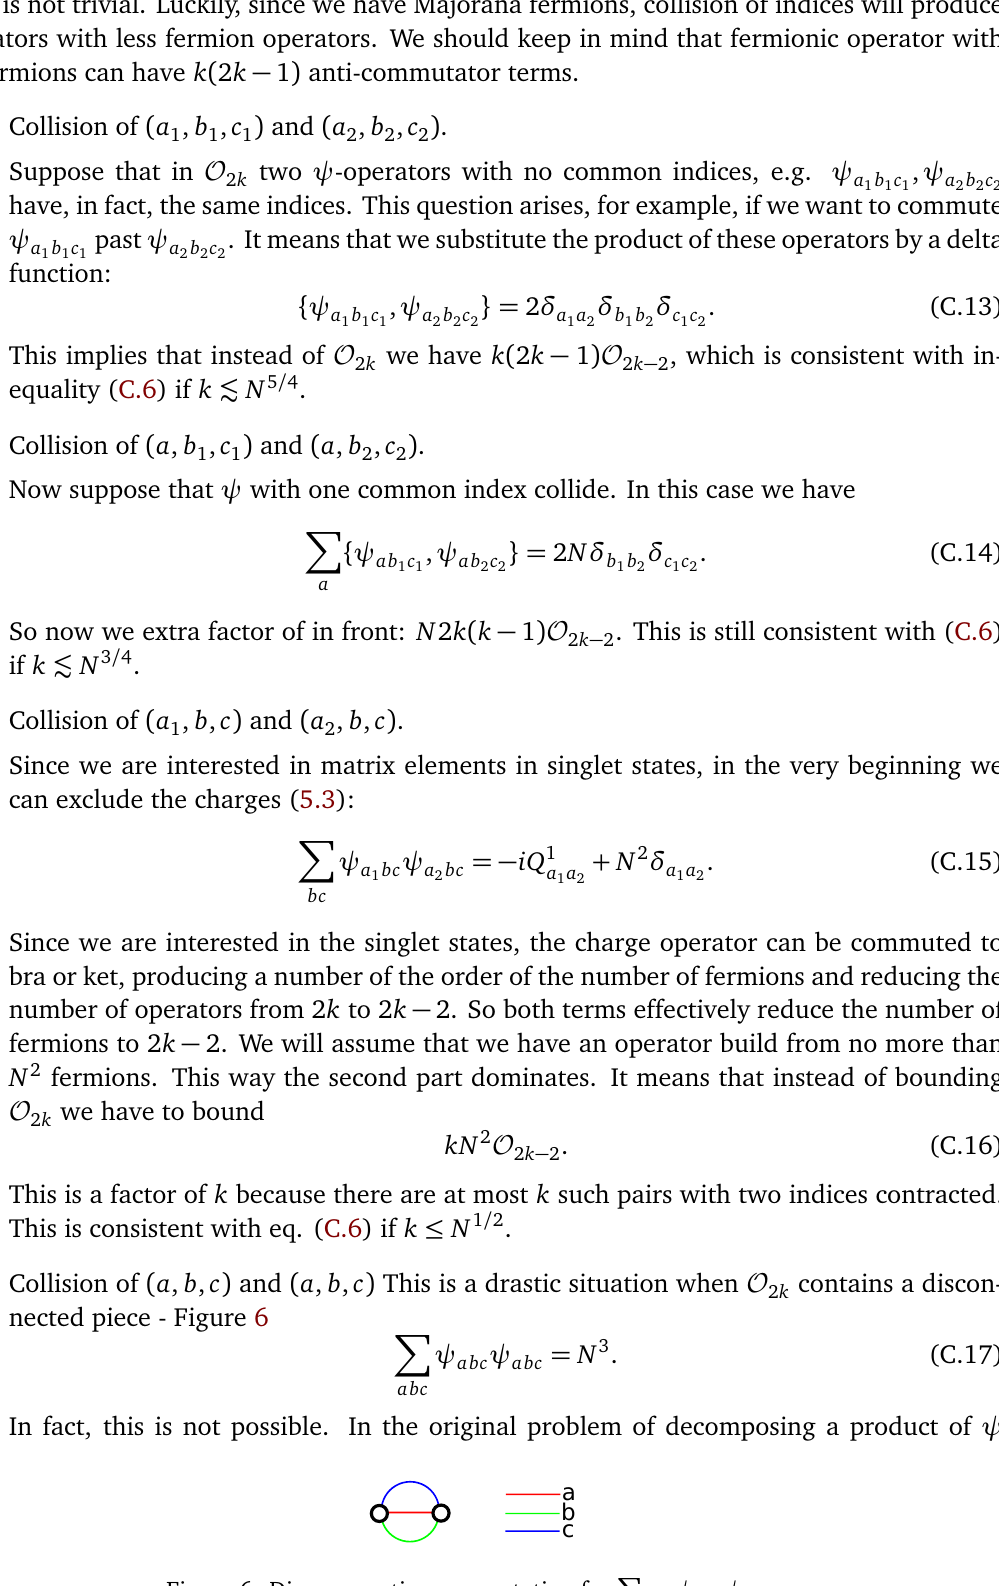
Figure 6: Diagrammatic representation for